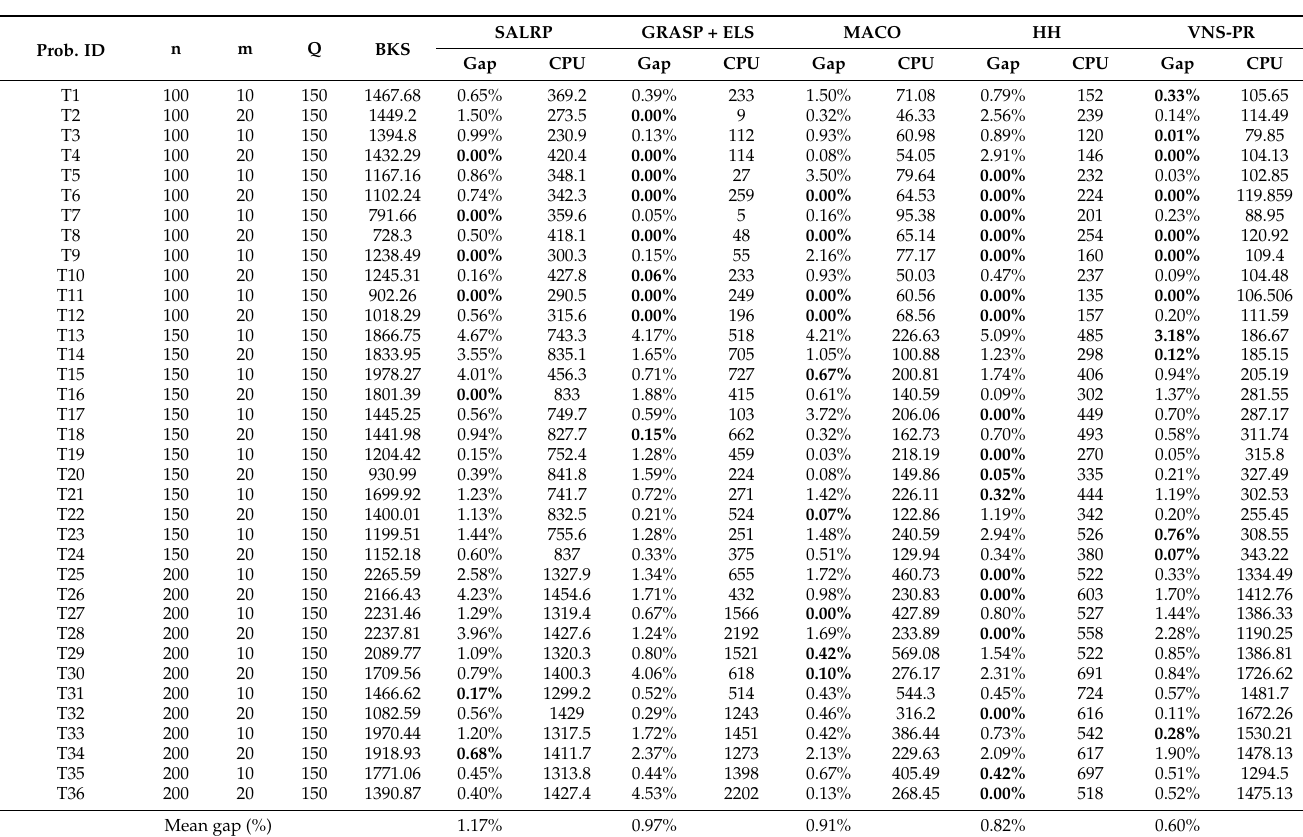
Table 4. Results of CLRP for the Tuzun and Burke’s [56] instances.